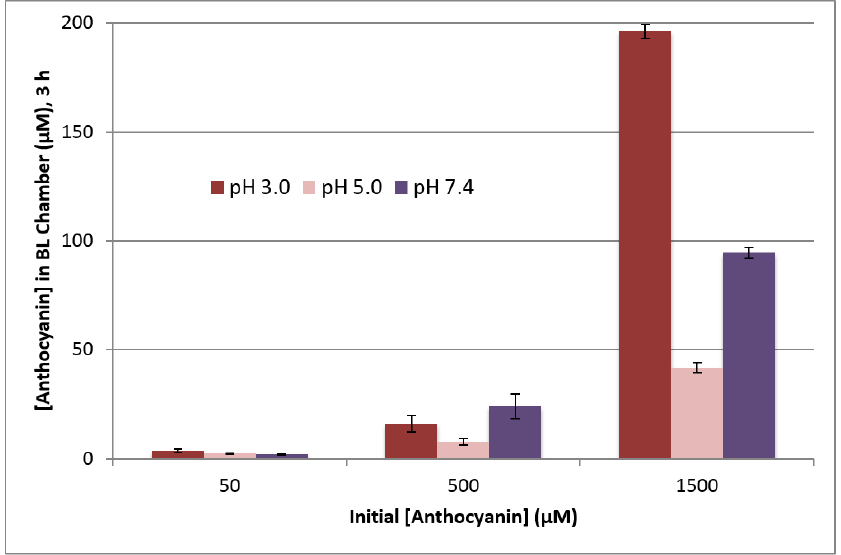
Figure 5. Effect of apical pH on the transport of chokeberry anthocyanins through the NCI-N87 cell monolayer after 3 h at 37 °C and basolateral pH 7.4 as determined by anthocyanin concentration in basolateral chamber. Table 2. Anthocyanin concentrations ( µ M) collected from basolateral chambers with varying apical pH values after 3 h treatment at 37 ◦